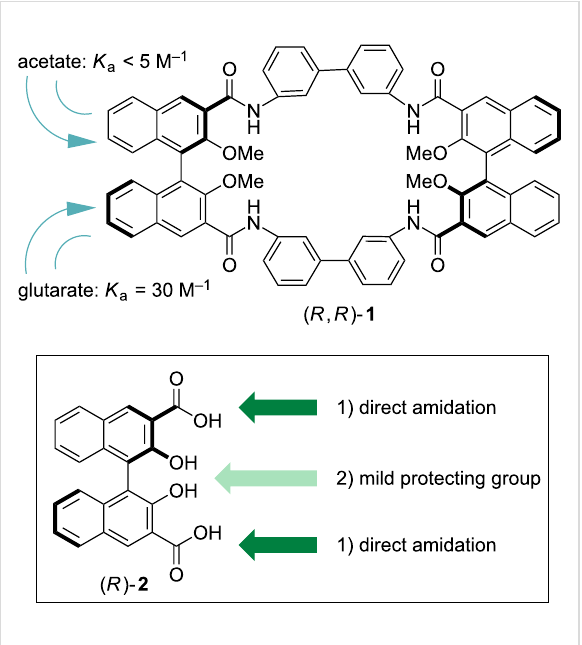
Figure 1: Structure of the macrocycle ( R , R )- 1 (top), and synthetic strategies for the production of novel amide-containing, axially chiral macrocycles